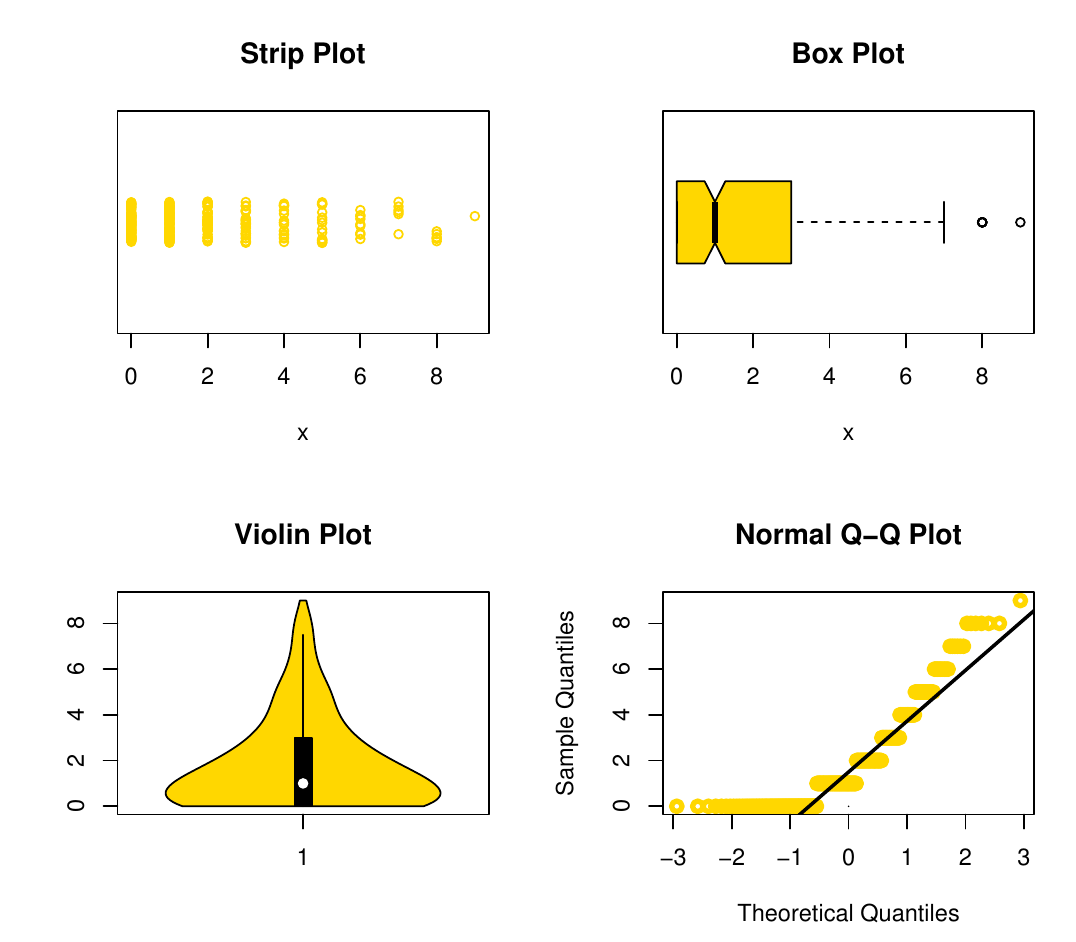
Figure 13. Nonparametric plots for data set